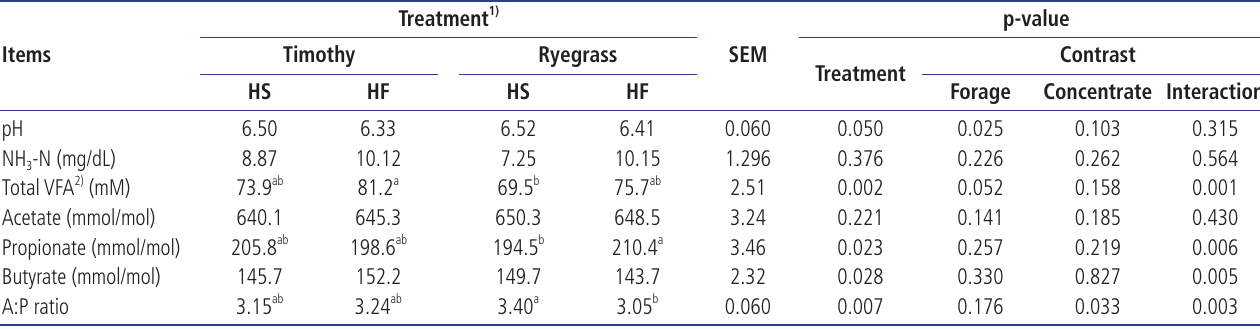
Table 4. Effect of the quality of forage and concentrate mix on rumen parameters in Hanwoo calves (n = 12)